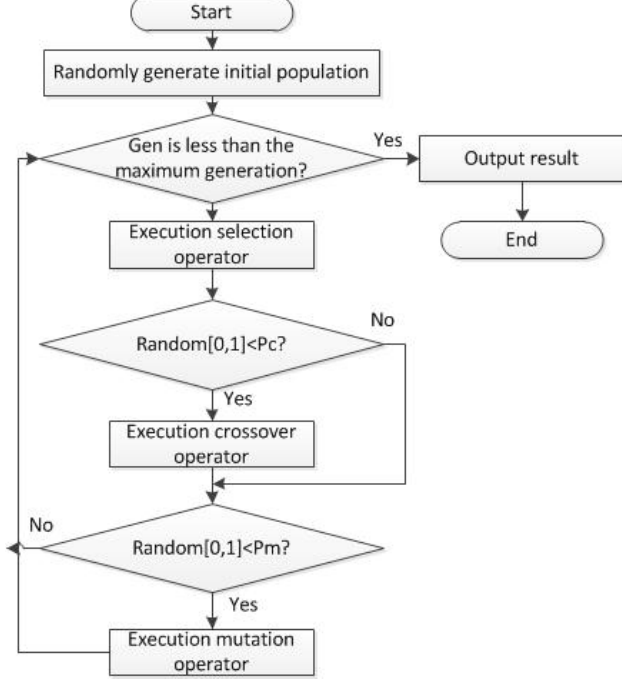
Figure 6. Genetic algorithm (GA) basic process.